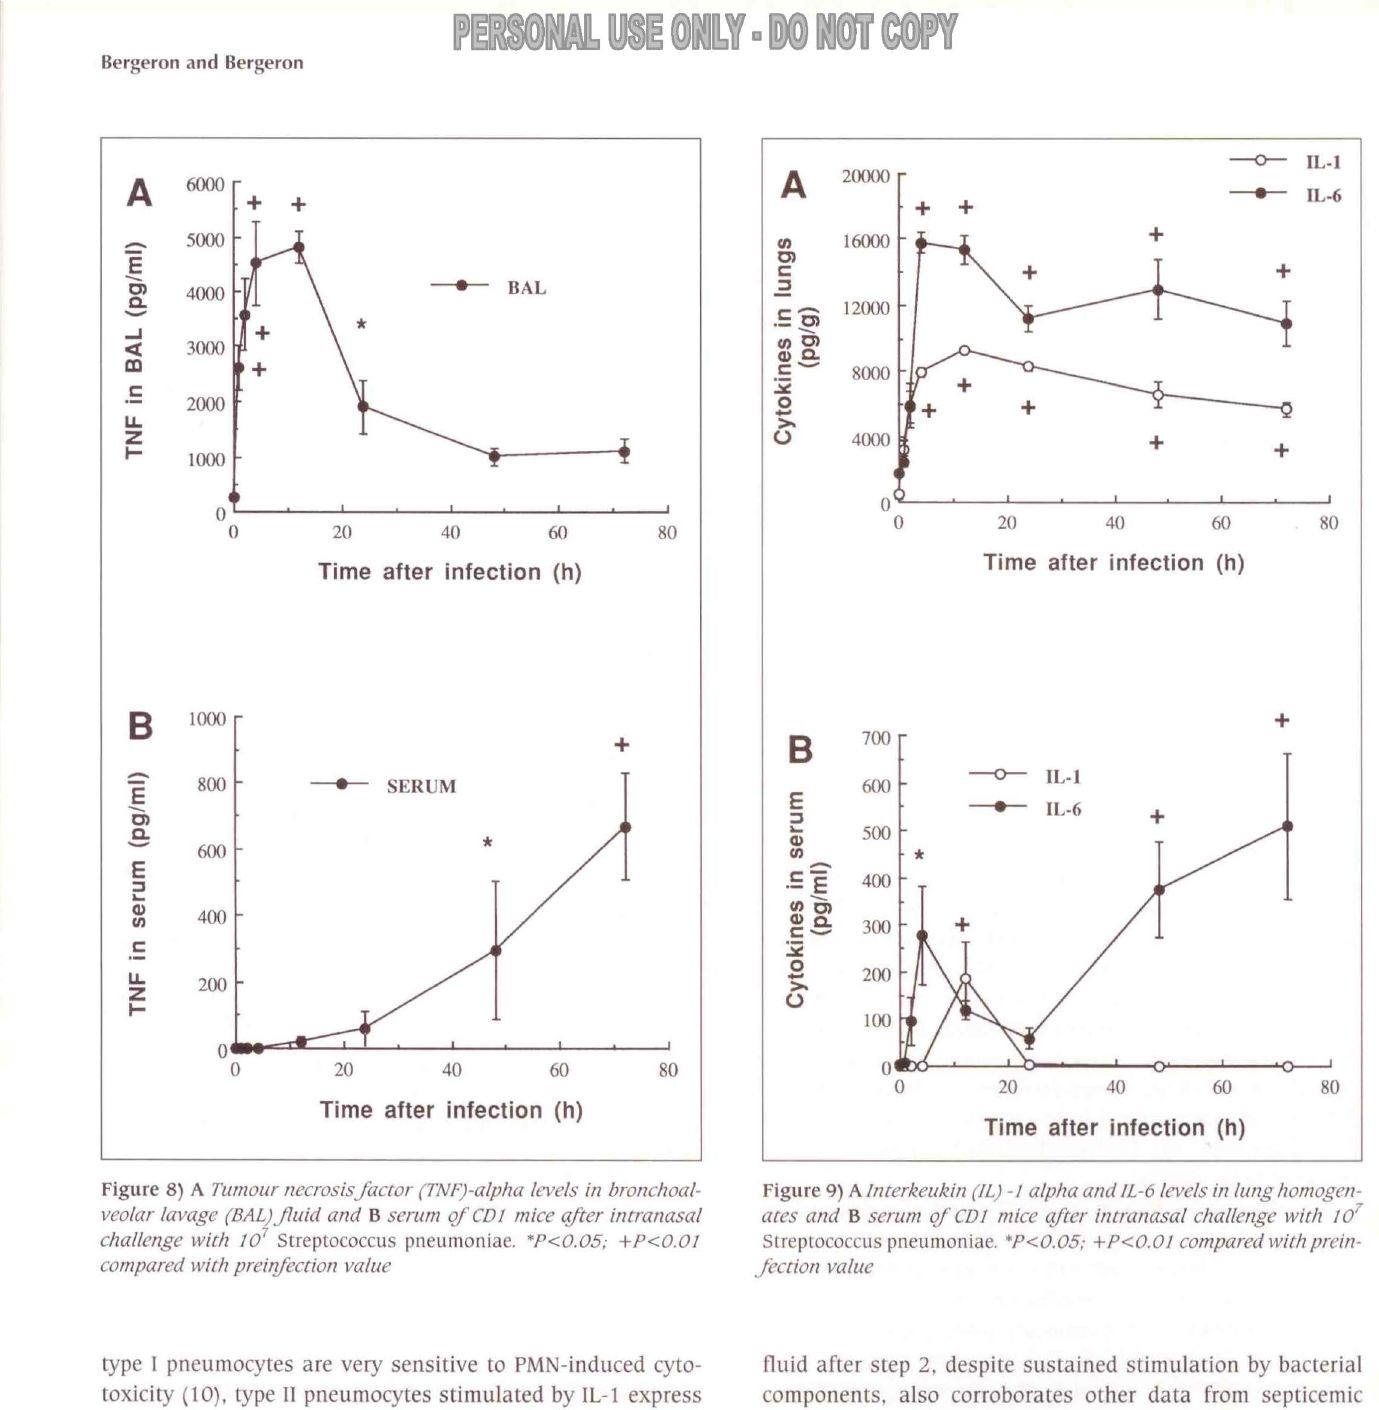
fluid after step 2, despite sustained stimulation by bacterial components, also corroborates other data from septicemic animals ( 109). Thus, in the context of pneumococcal pneumo presepticemic and septicemic phases of